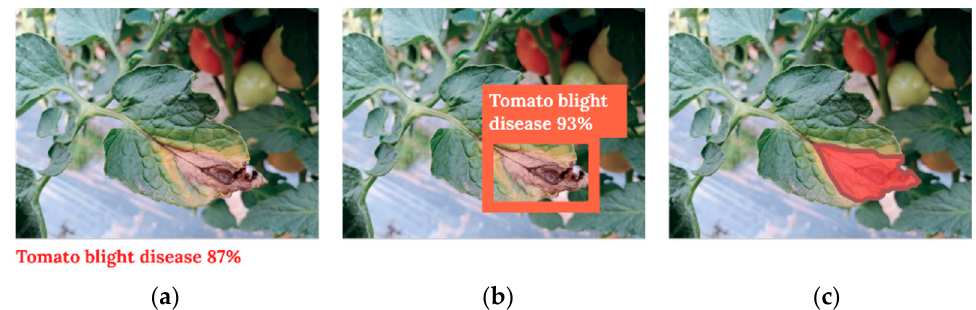
Figure 6. Object recognition techniques: ( a ) image classification, ( b ) object detection, and ( c ) seg- mentation.